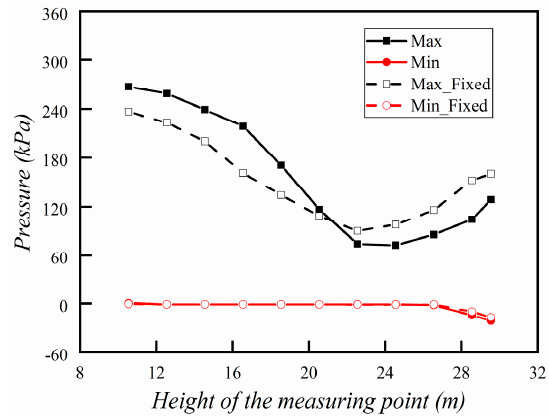
Figure 19. Wave slam pressure distribution on the surface measurement points at different height positions with the column in six degrees of freedom of movement and fixation.